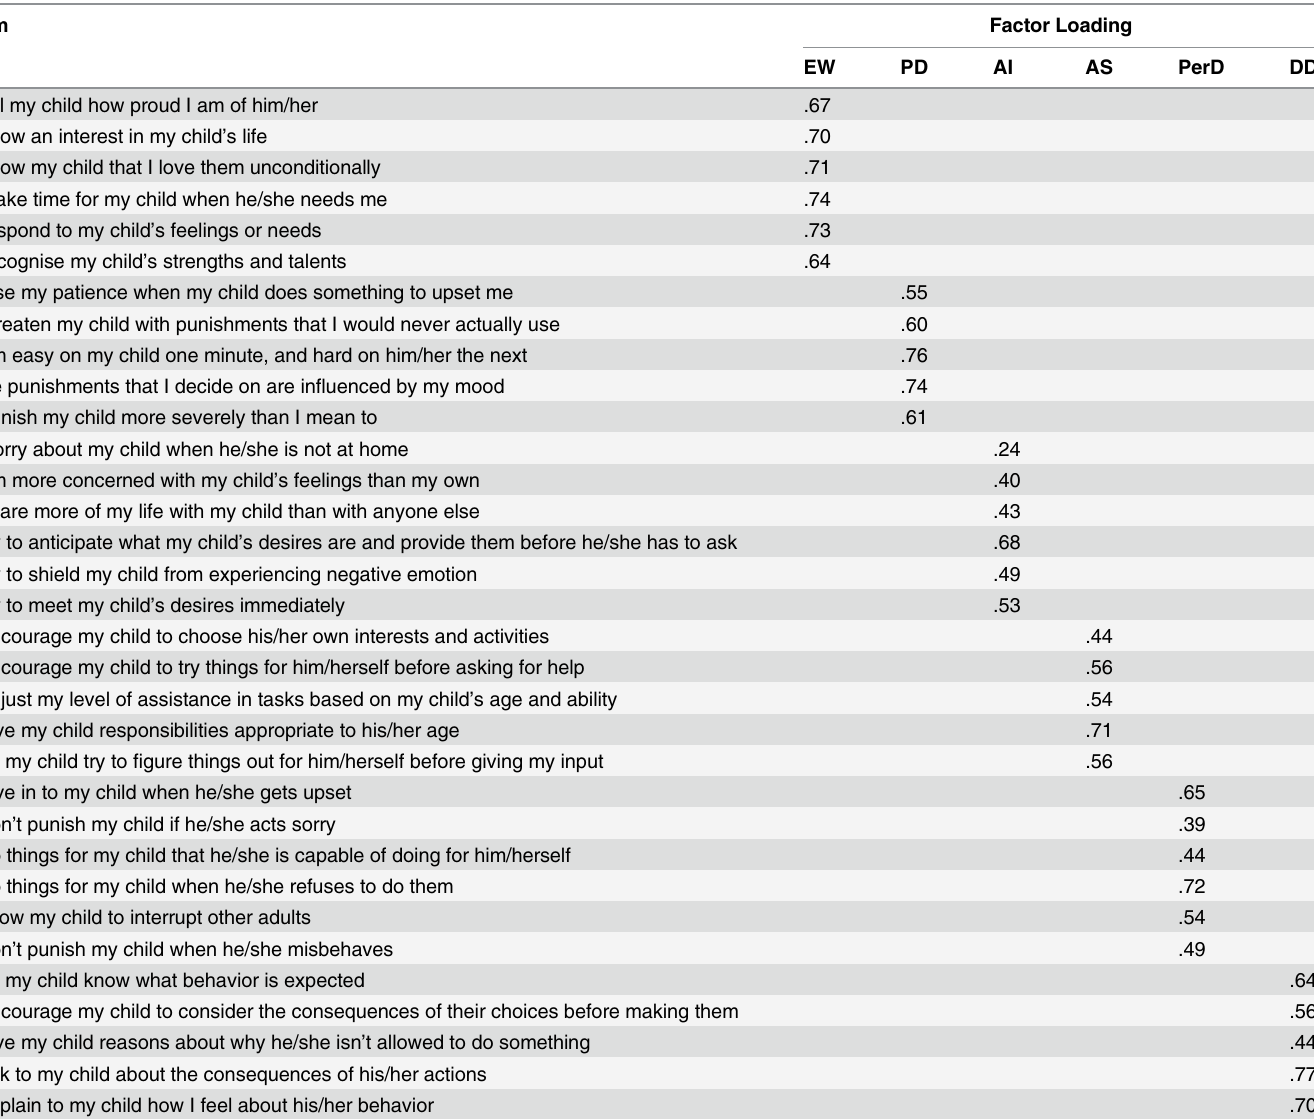
Table 4. Final Pattern Factor Loading Matrix for